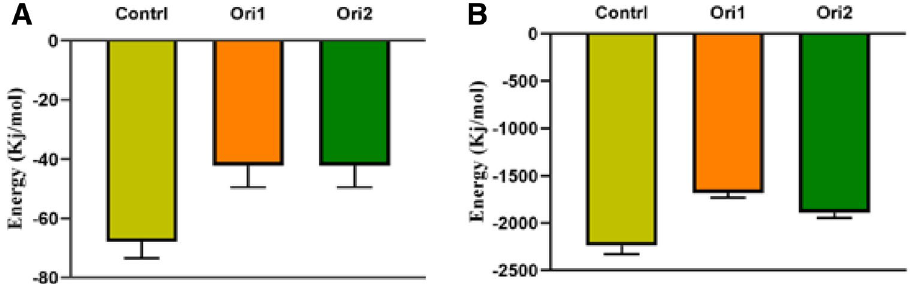
Figure 8. The VdW and electrostatic energies for control, orientation1, and orienation2 systems during the last 300 ns of MD